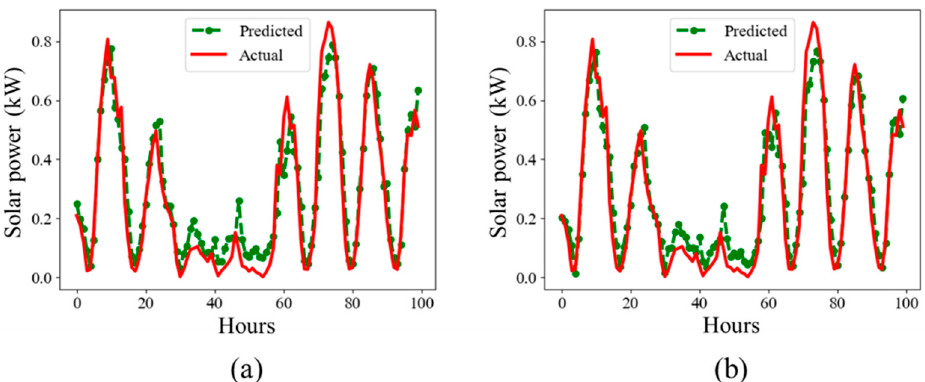
Figure 6. Visual results on hourly solar data, where ( a ) is the ED prediction graph, while ( b ) is the proposed AB-Net model prediction graph for solar power in proposed AB-Net model prediction graph for solar power in kW.